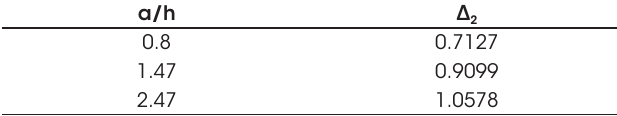
Ratio between flexural toughness